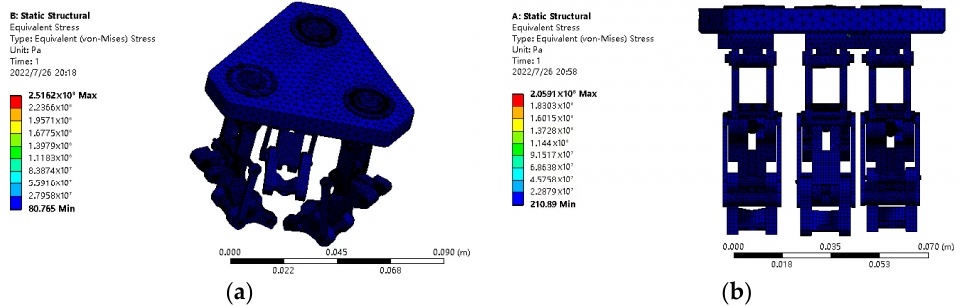
Figure 11. Simulation of gripper stress at different grasping methods. ( a ) Three-finger symmetrical grasp; ( b ) Three-finger parallel grasp.